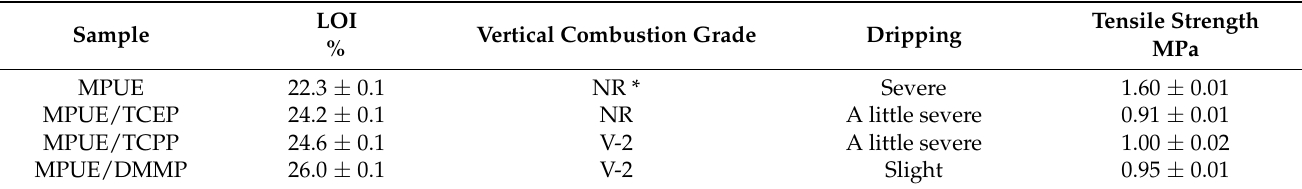
Table 4. Effect of liquid flame retardant on the overall properties of MPUE.